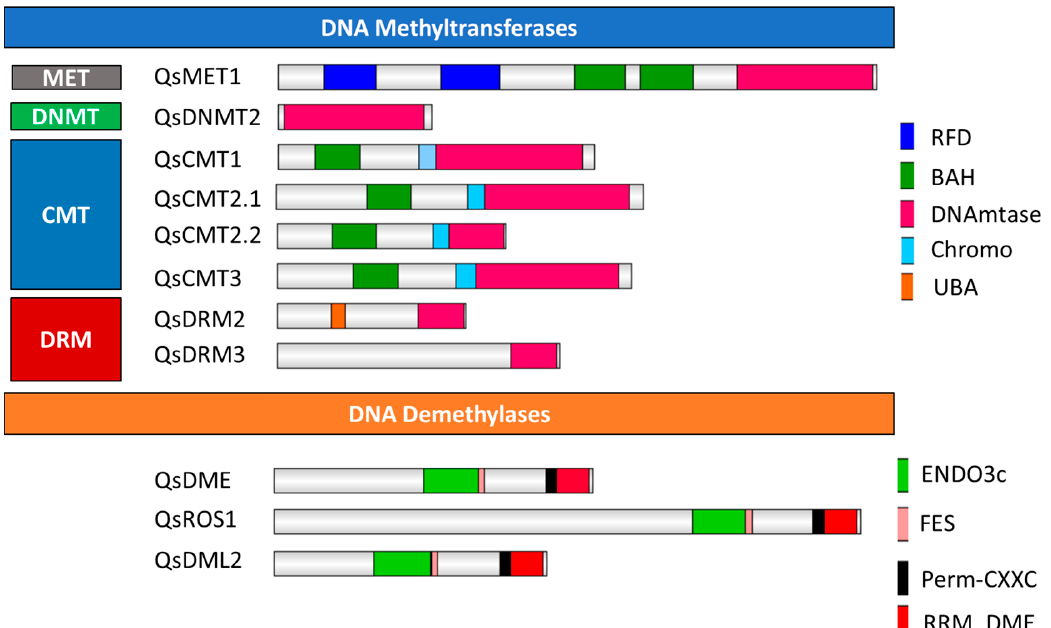
Figure 1. Domain organization of the Quercus suber L. DNA methyltransferases and demethylases proteins. Schematic diagrams show the domain organization of the enzymes. The proteins and the family they belong to are indicated on the left side of each corresponding schematic diagram. The different conserved protein domains are depicted in different colors as indicated in the legend on the right. C-5 cytosine methyltransferase (IPR001525) is the conserved domain common to all proteins. Replication foci domain RFD (PF12047) and bromo adjacent homology (BAH) domain (PF01426) are present in QsMET1, while chromodomain (CHR) (PF00385) are conserved in chromomethylase proteins. The UBA domain (PF00627) is identified in QsDRM2. The ENDO3c (PF00730), FES (SM000525), Perm-CXXC (PF15629), and RRM_DME (PF15628) domains are present in all DDME.